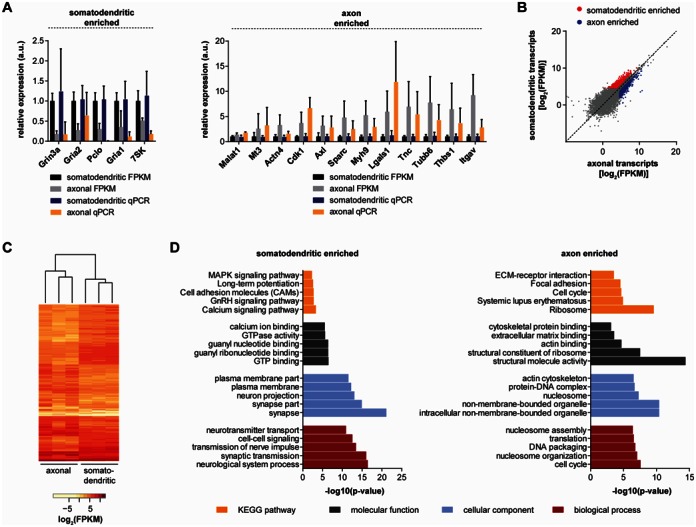
Detection of transcripts enriched on the somatodendritic and axonal side of compartmentalized motoneurons. (A) Validation of candidate transcripts enriched in the somatodendritic or axonal compartments of cultured motoneurons by qPCR. Data are mean with standard deviation relative to the mean of the somatodendritic datasets. Gapdh was used as internal control. (B) Differential expression analysis of whole transcriptome profiling data from compartmentalized motoneurons. Significantly enriched (q < 0.05) transcripts are color-coded. (C) Unsupervised clustering of the differentially expressed transcripts. (D) GO term analysis of transcripts enriched significantly (q < 0.05) on the somatodendritic or axonal side of compartmentalized motoneurons and not changed significantly between undiluted and diluted somatodendritic RNA. The bar diagrams show the top five terms for each GO category as well as for the KEGG pathway analysis.